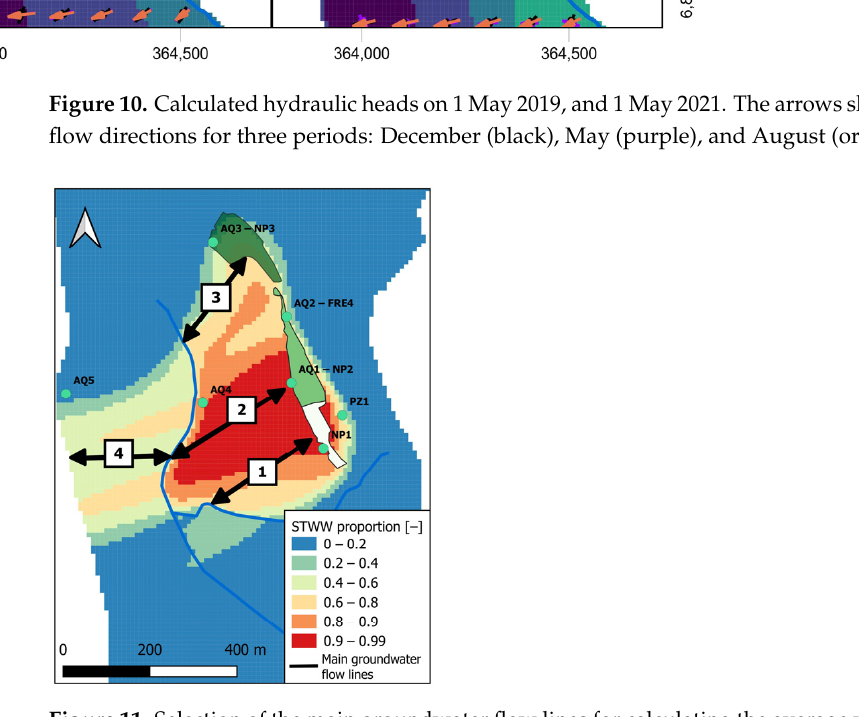
Figure 11. Selection of the main groundwater flow lines for calculating the average velocities be- tween infiltration ponds 1, 2, and 3 and the Goulot, and 4 between the Goulot and the sea.